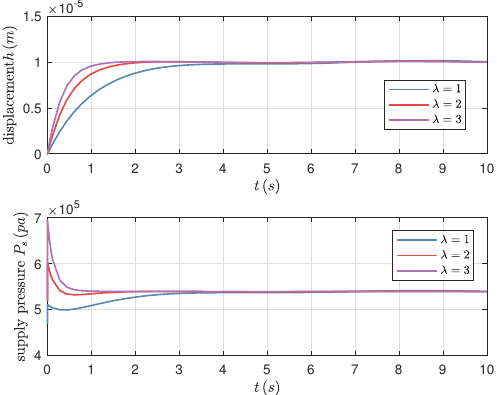
Figure 7. Control input and tracking performance under λ =